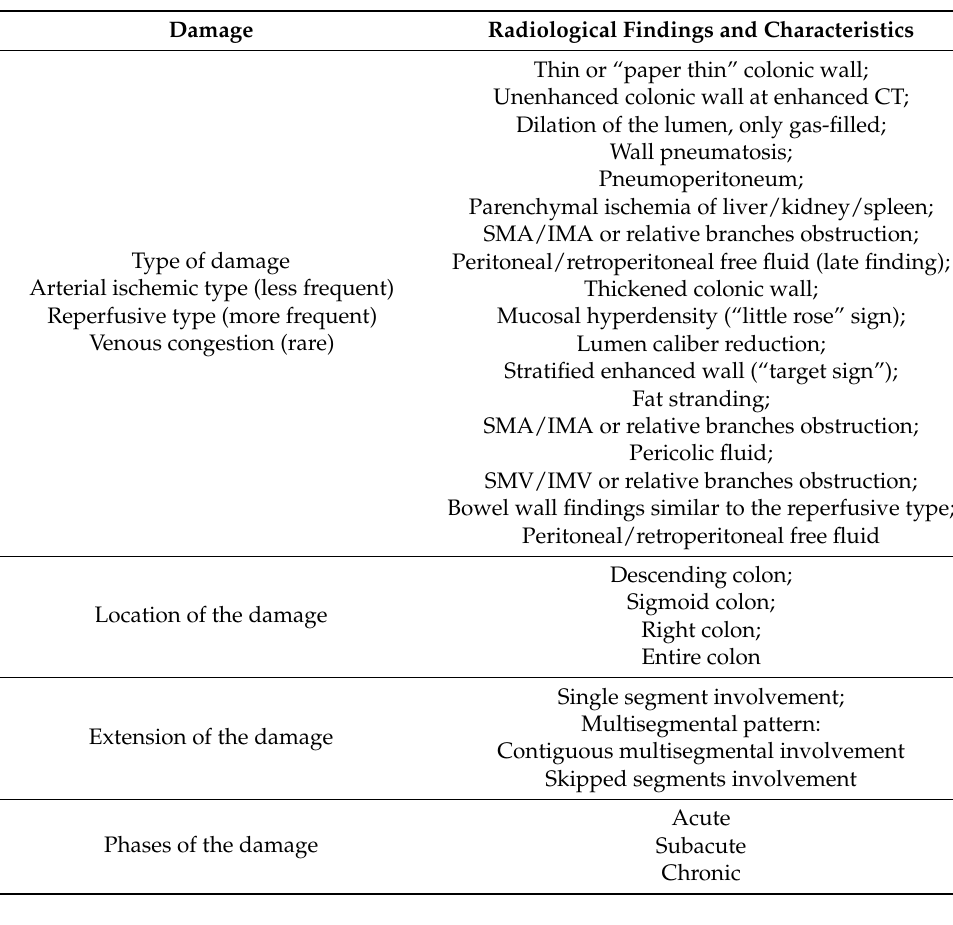
Table 2. Abdominal CT imaging finding in patients with